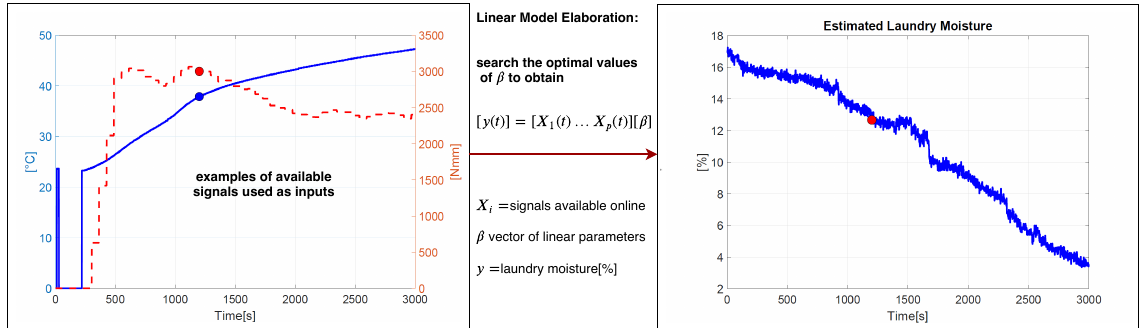
Figure 2. A Visual explanation of the algorithm proposed as Method 1. For each time sample, an estimation value is available (e.g., dot depicted in each